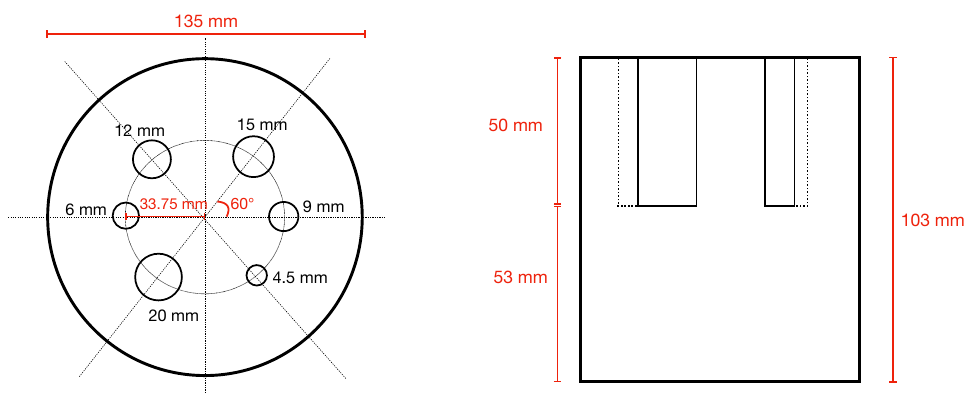
Figure 3. Top and transverse view of simulated phantom. Near each rod the diameter of the rod is indicated (in